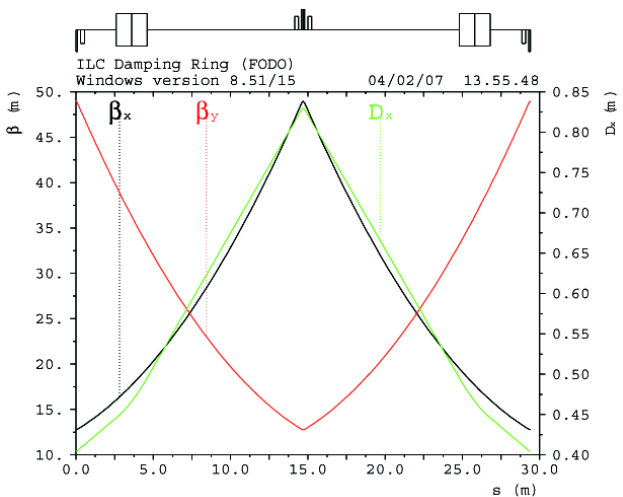
FIG. 2. (Color) Lattice functions in the 72 = 72 degree arc